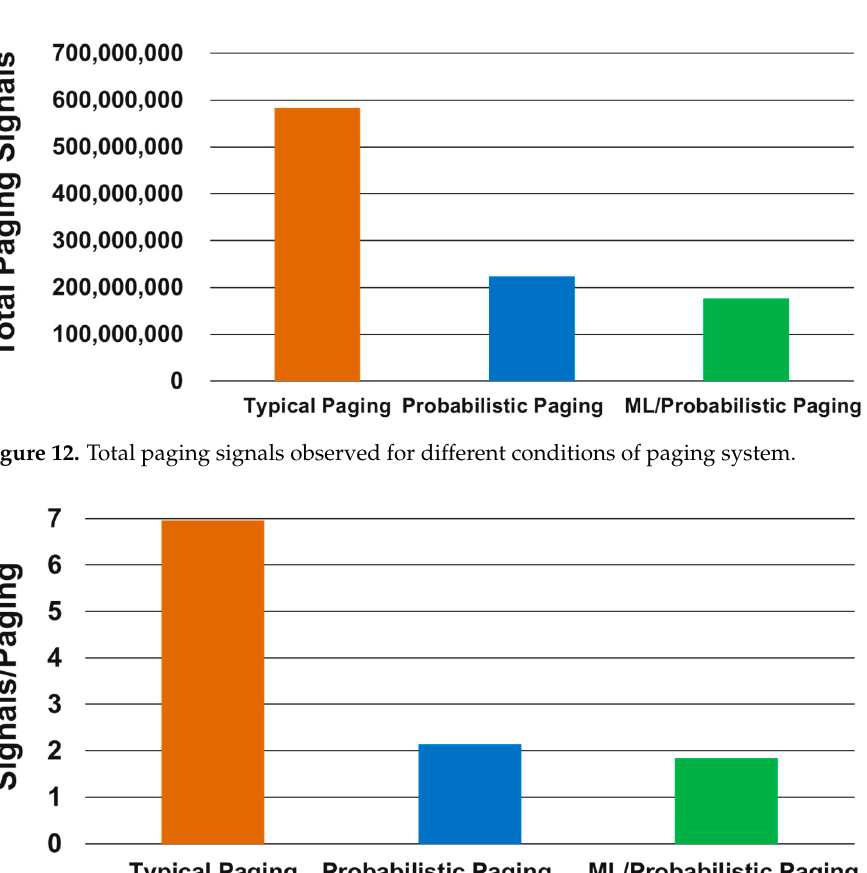
Figure 13. Average paging signals observed for different conditions of paging system.